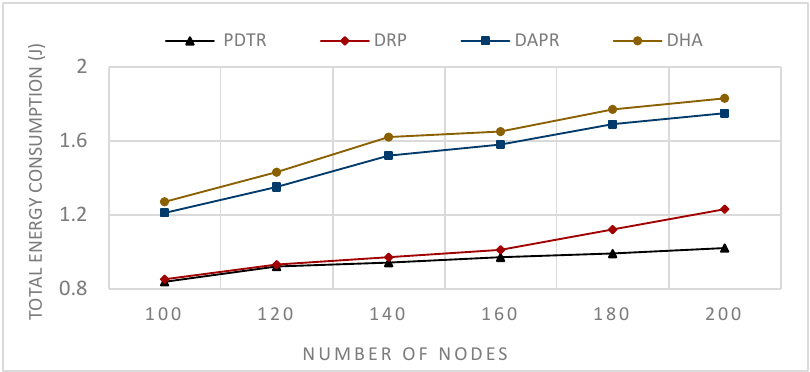
Figure 9. Impact of varying number of nodes on total energy consumption.